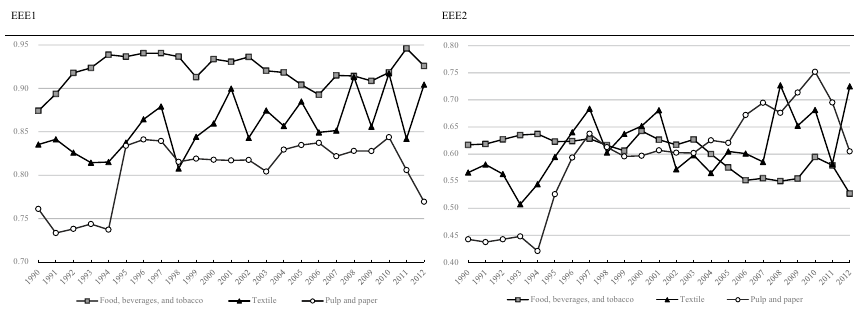
Fig. 2 Changes in EEE1 and EEE2 by light industry (1990–2012). The values in the figure are the arithmetic mean of each industry based on the measurement results by prefecture